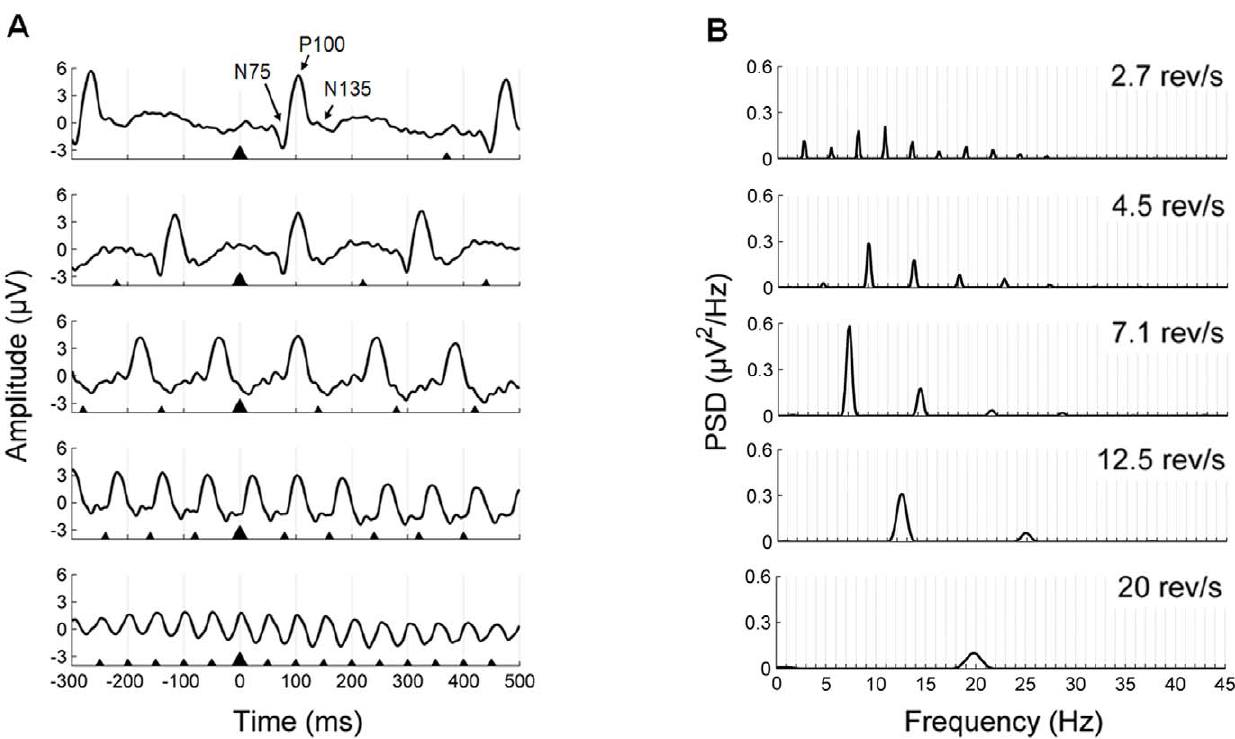
Figure 3. Recorded isochronic waveforms (Experiment 1). A , Grand-average waveforms (800 ms time window, including 300 ms pre-stimulus activity) for the five isochronic conditions. The typical deflections of the pattern reversal ERP (N75 at 70–90 ms, P100 at 80–120 ms and N135 at 120– 180 ms) are indicated in the grand-average for the 2.7 rev/s condition. The triangles placed below the waveforms indicate the timing of stimuli appearance; the largest triangle represents the zero time point. B , Power spectral densities of the grand-average waveforms for the five